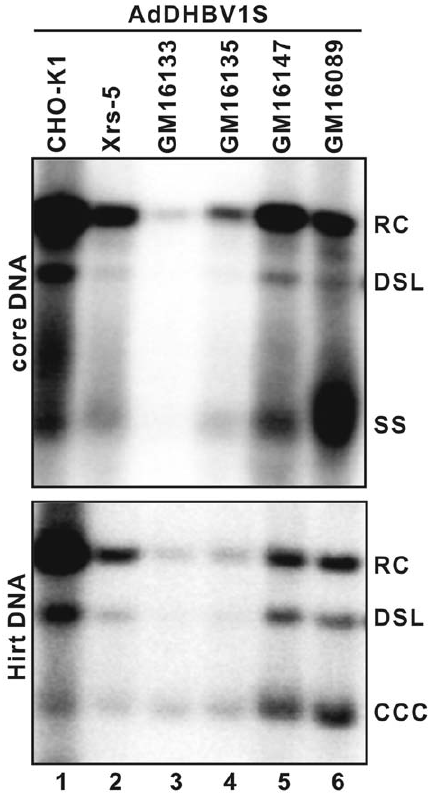
Figure 3. DHBV DNA replication and cccDNA formation in a panel of cells lines that are defective in NHEJ DNA repair pathway. Cell lines used in this experiment are CHO-K1 and its derived cell line Xrs-5 harboring defective gene of the p86 subunit of the Ku autoantigen, four human fibroblast cell lines GM16133, GM16135, GM16147 and GM16089 that are defective in XRCC1, the catalytic subunit of DNA-PK, XRCC4 and ligase IV, respectively. The cells are infected with AdDHBV1S at a MOI of 10 and infected cells are harvested on day 3 post infection. DHBV core-associated (upper panel) and Hirt DNA (lower panel) were extracted and analyzed by Southern blot hybridization.